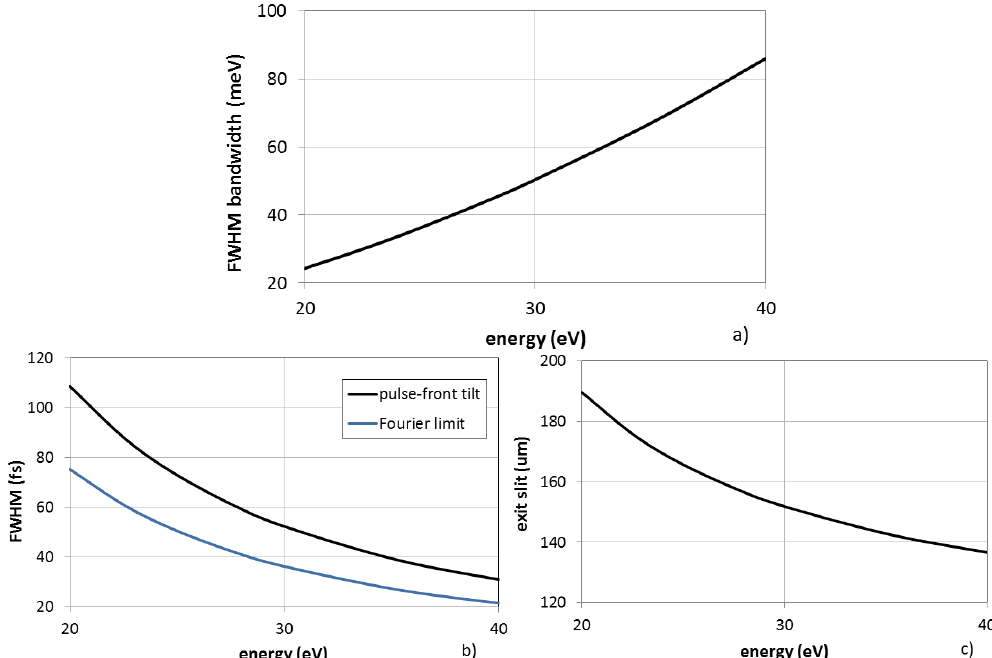
Figure 4. OPM ultrafast monochromator with a Gaussian diffraction-limited input source, 100 μm full size. The grating parameters are reported in Table 1. ( a ) Energy bandwidth on the exit slit, that has a fixed width of 100-μm; ( b ) Temporal response of the monochromator: pulse-front tilt and Fourier limit. 4. Single-Grating Monochromators for HHs In real applications, a trade-off has to be accepted between high energy resolution and high temporal resolution when single-grating designs are adopted, giving a pulse-front tilt that is definitely beyond the Fourier limit. Here, we discuss the optical design of a grating monochromator for HHs. Monochromators and spectrometers for HHs are typically operated without an entrance slit [36], with the HH source itself being very small in extension. The HH divergence in the plateau region depends on the generation geometry [37–41] and is typically in the few-mrad range. Here, we assume to deal with the 14–45 eV region, that is the region normally covered by HHs generated in argon, with an average energy bandwidth of 100 meV. This is a typical requirement for pump–probe experiments on solid-state samples. We will design a monochromator using the OPM geometry.